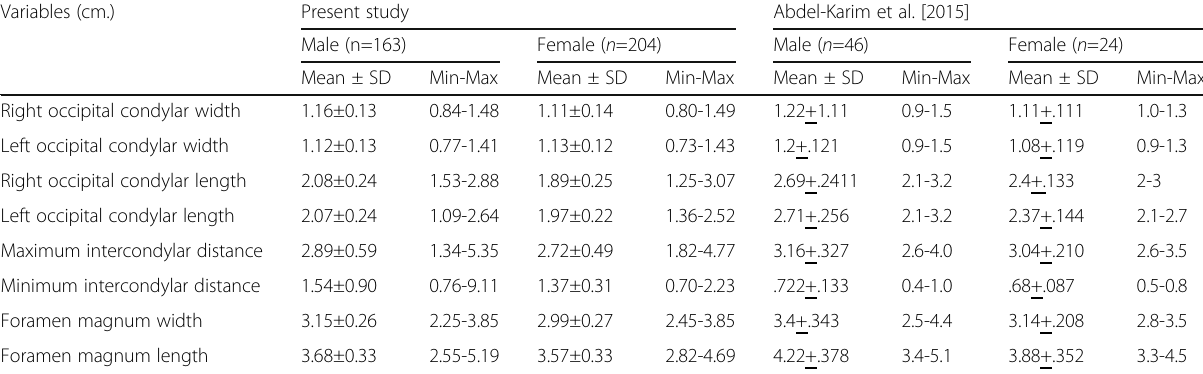
Table 7 Comparative results between the present work and Abdel-Karim et al. study Variables